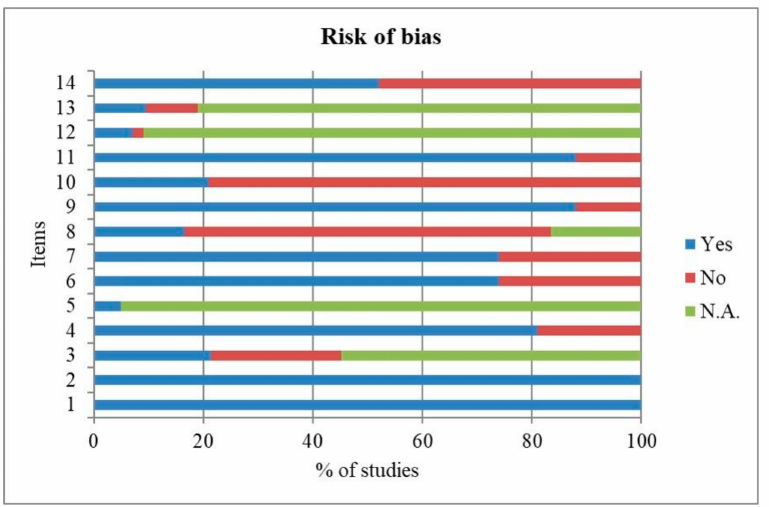
Figure 4. Frequencies (%) of risk of bias assessment according to the National Institutes